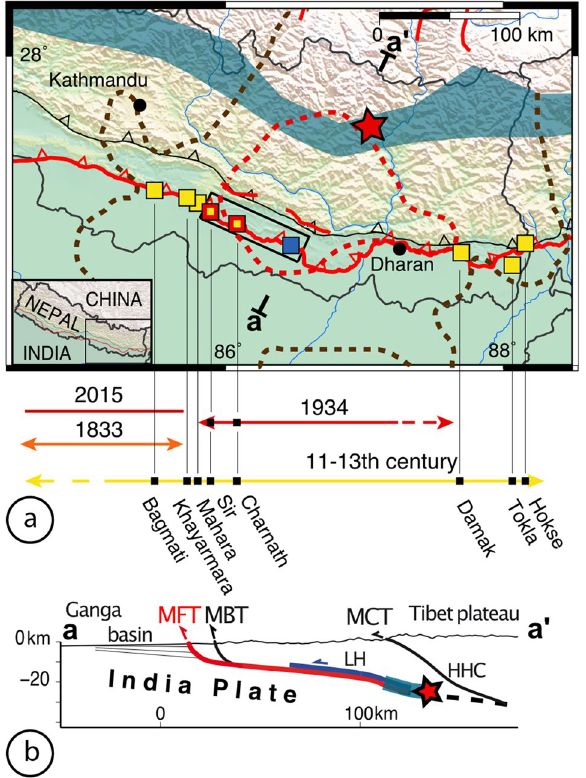
Figure 1. Seismotectonic map of central-eastern Nepal. ( a ) Yellow and red squares locate the paleoseismic sites excavated through paleoruptures dating from medieval times and the surface rupture of the 1934 earthquake, respectively 20–22,24,26–28,34 ). Blue square: Khutti Khola trench site. Red star locates the instrumental epicenter of the 1934 Bihar–Nepal earthquake 35 . Brown and red dashed lines represent respectively the isoseists of intensities VII and VIII corrected for liquefaction effects 32,33 . Black rectangle locates Fig. 2. ( b ) Cross section a–a ′ across the range in eastern Nepal. Partial and total ruptures of the Main Himalayan Thrust are schematically represented in blue and red respectively. MFT Main Frontal Thrust, MBT Main Boundary Thrust, MCT Main Central